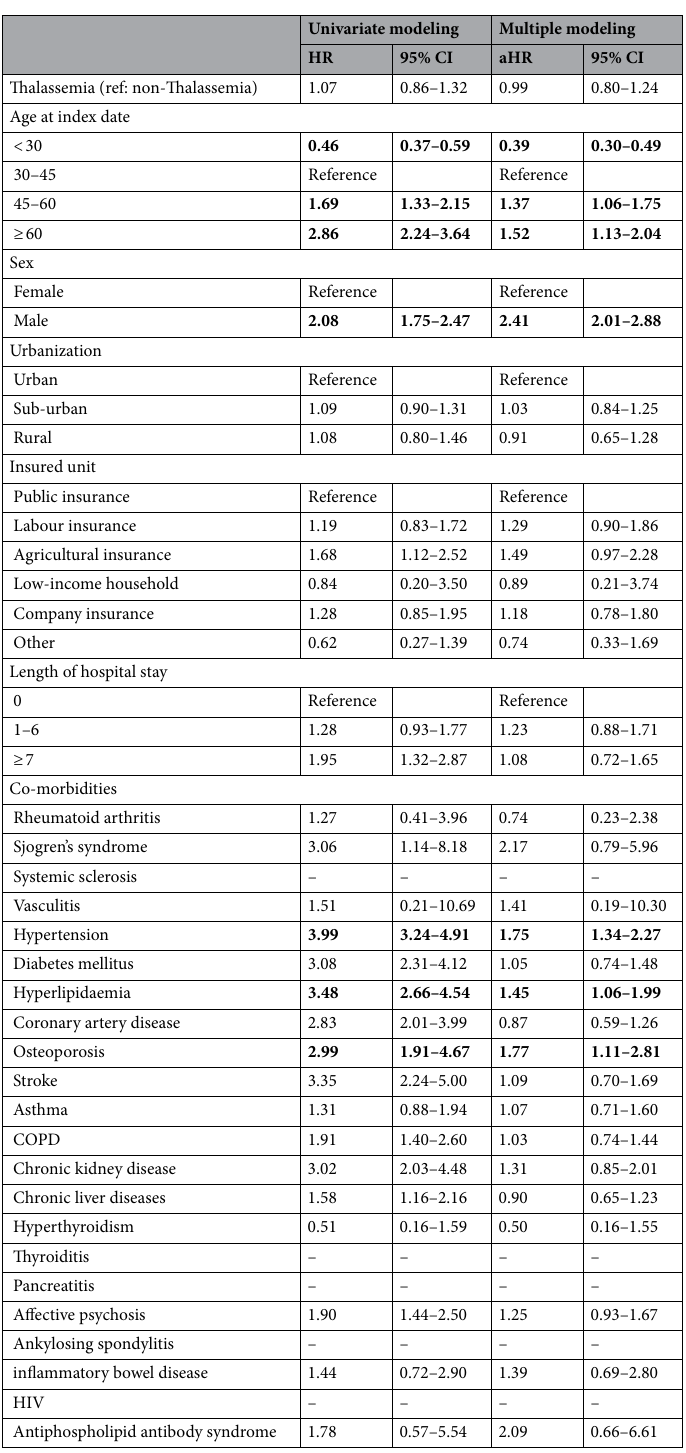
Table 3. Estimation the hazard ratio of gout arthritis by using Cox proportional hazard regression before